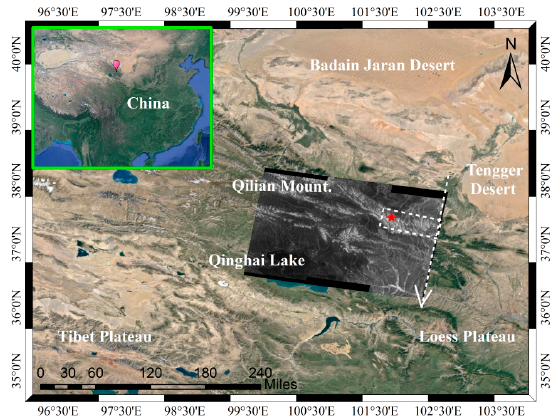
Figure 1. The geographical location of the Menyuan earthquake. A descending Sentinel-1A SAR image acquired on 18 January 2016 is superimposed on a GoogleMaps™ image; the dashed rectangle shows the burst for interferogram generation, the red star marks the M S 6.4 Menyuan earthquake epicenter.